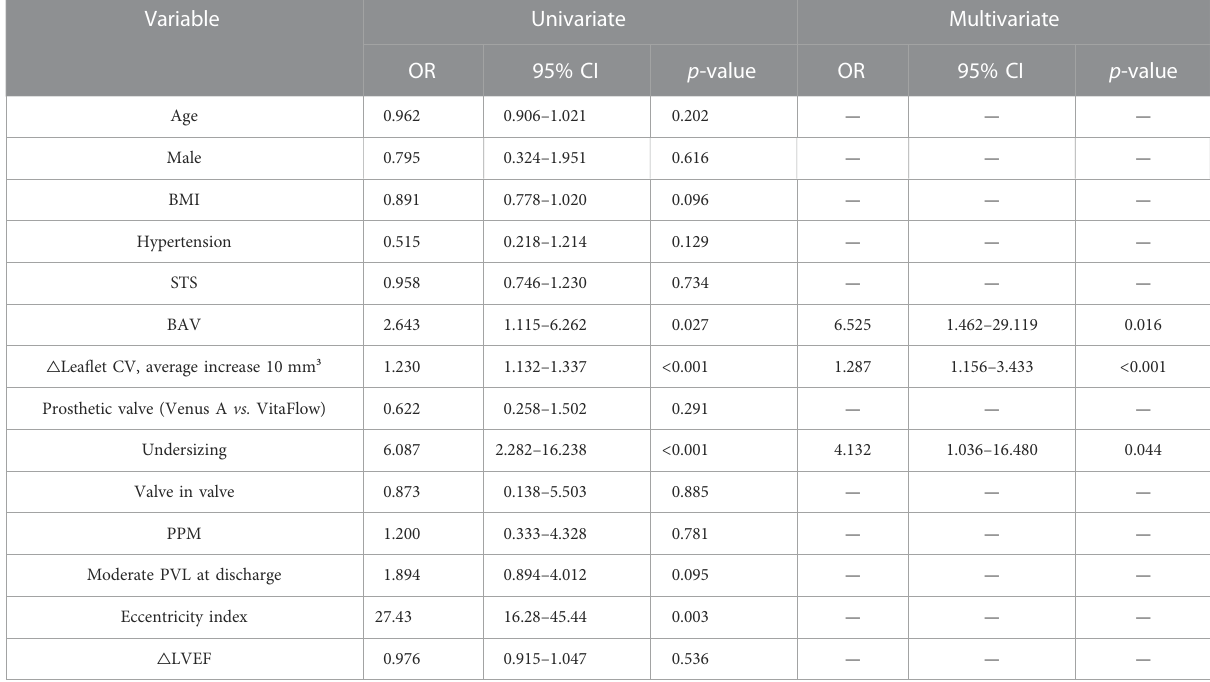
TABLE 4 Independent predictors for the failure of improvement in PVL by lower than one grade at a 1-year follow-up after